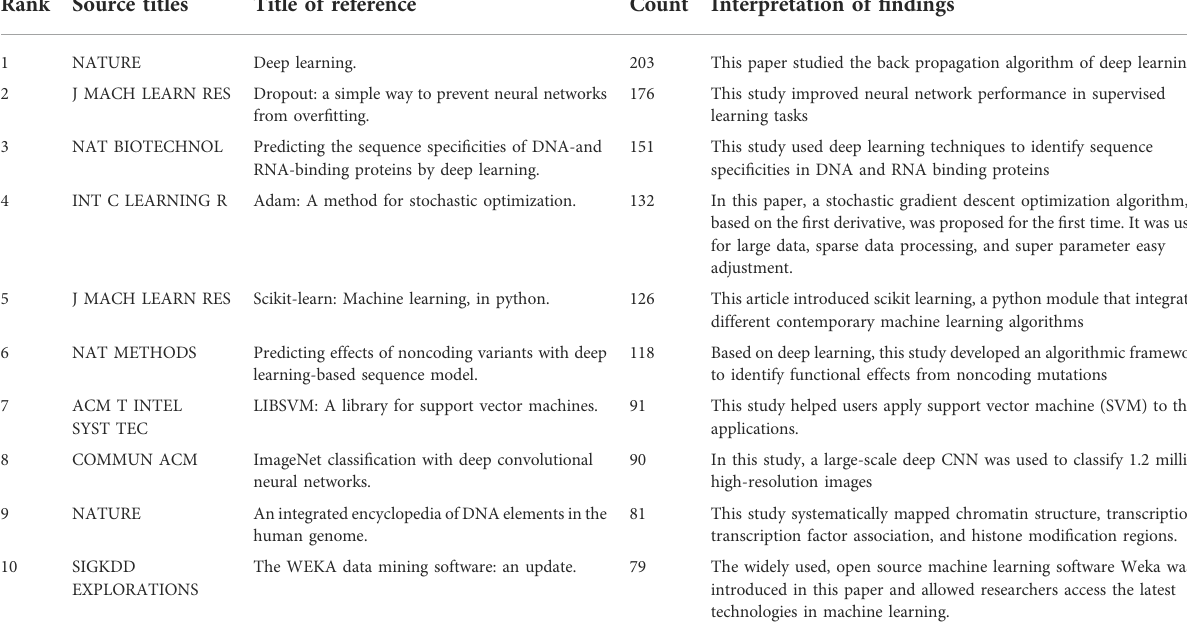
TABLE 2 Top 10 cited references on arti fi cial intelligence for biotechnology and applied